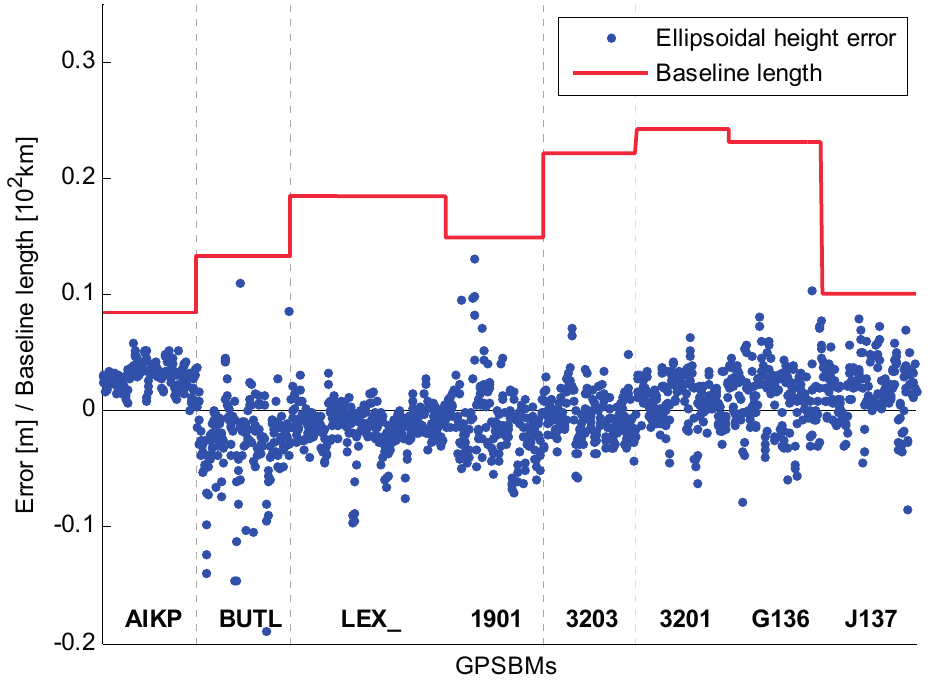
Figure 8. Errors and baseline lengths by antenna type (TRM57971.00 NONE) for Phase